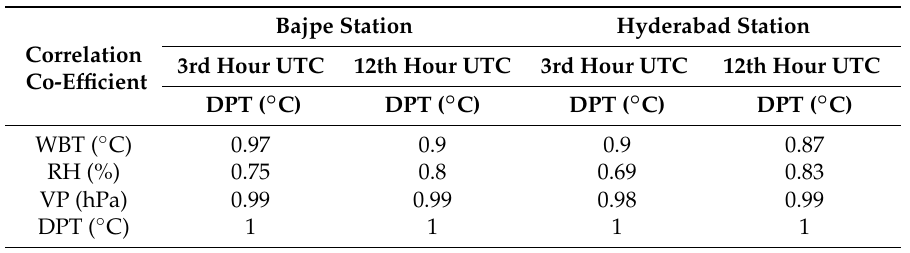
Table 1. Correlation coefficient statistic of DPT with other model input attributes.